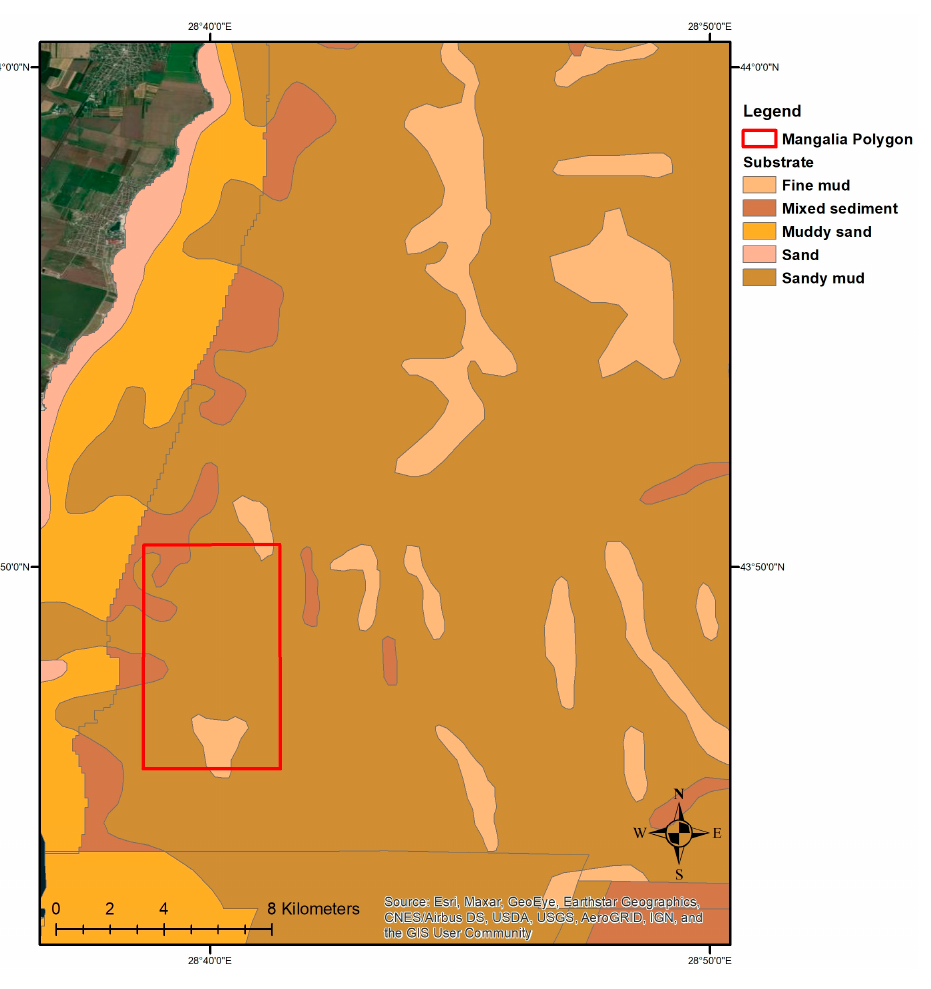
Figure 8. Seabed configuration in the Mangalia area .